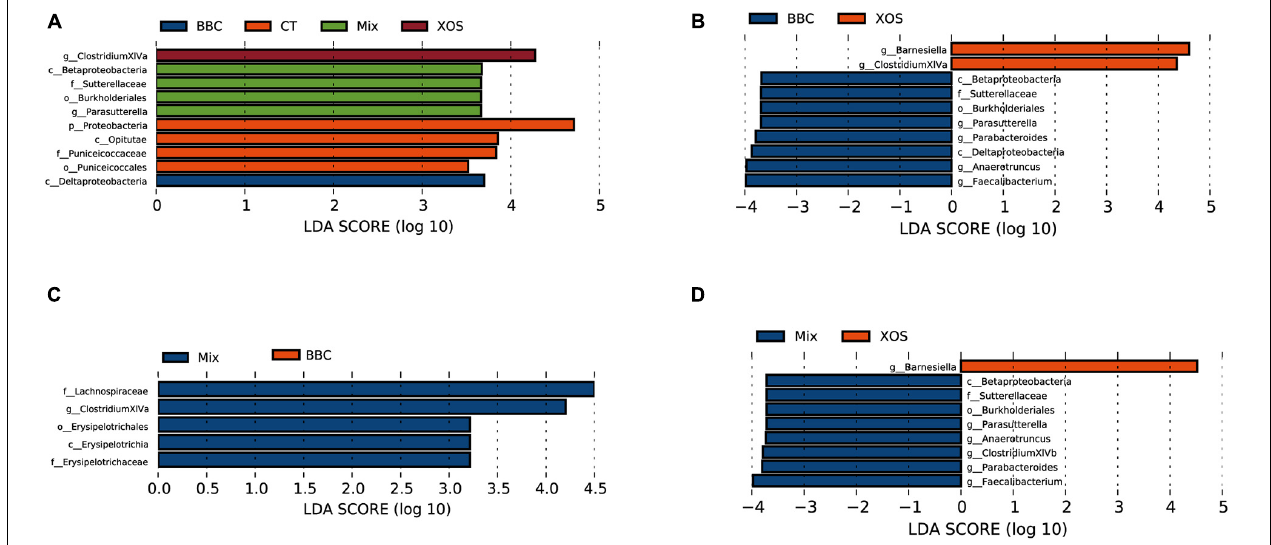
FIGURE 3 | LDA scores of the significant biomarkers among four groups (A) , BBC vs XOS group (B) , MIX vs BBC group (C) and MIX vs XOS group (D)